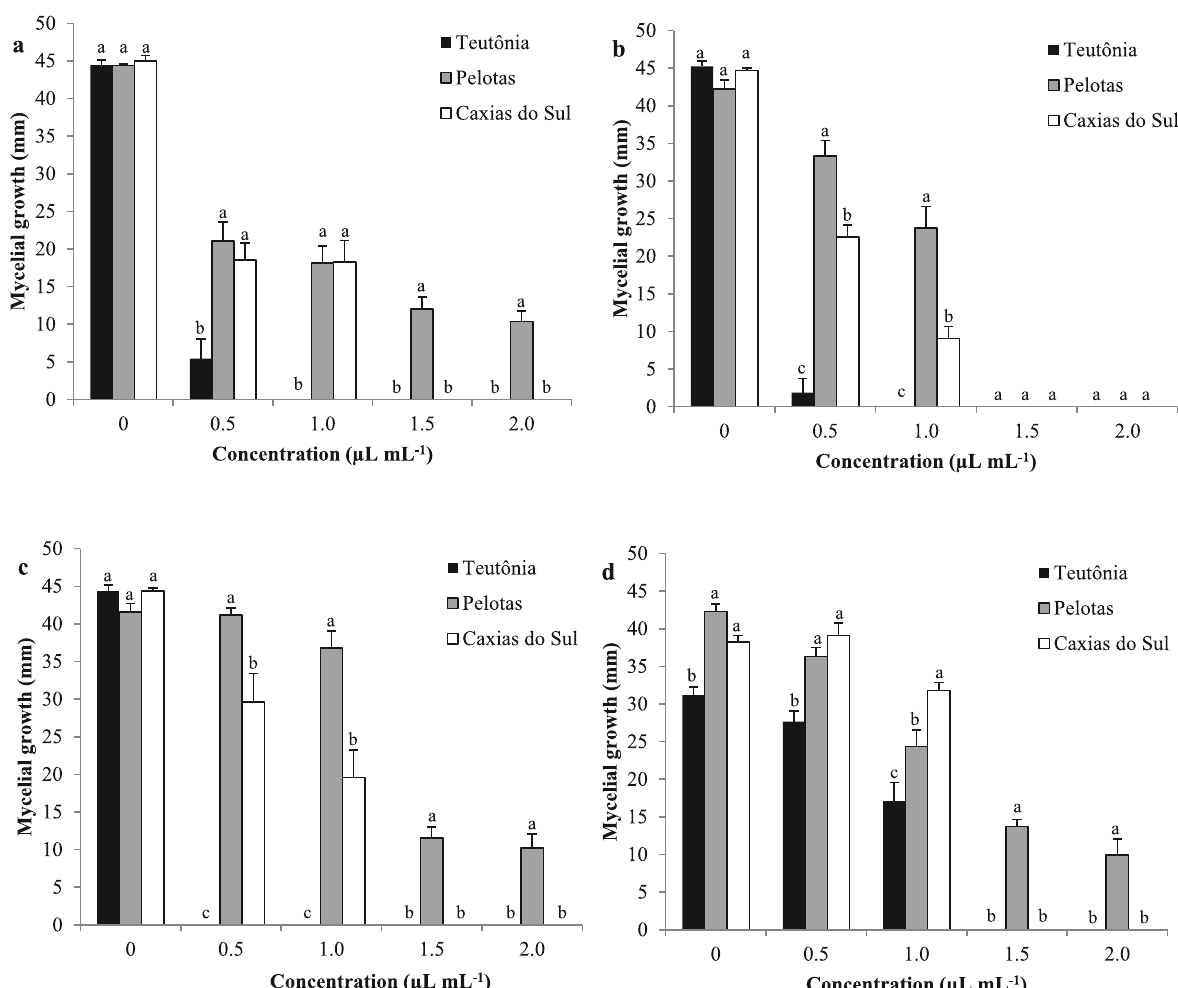
Figure 2 - Comparison between three chemotypes of Lippia alba essential oils on the mycelial growth of four Alternaria solani isolates on solid media on the 7 th day. The chemotypes were: Teutônia accession - citral chemotype, Pelotas accession – camphor/1,8- cineole chemotype and Caxias do Sul accession – linalool chemotype. a ) Isolate A03/09, b ) Isolate A11/09, c ) Isolate A1033 and d ) Isolate A13/09. Values are the mean of ten replicates. Error bars indicate standard error. Letters indicate the comparison between chemotypes for each concentration. Means followed by same letter do not differ regarding the Tukey test (p ≤